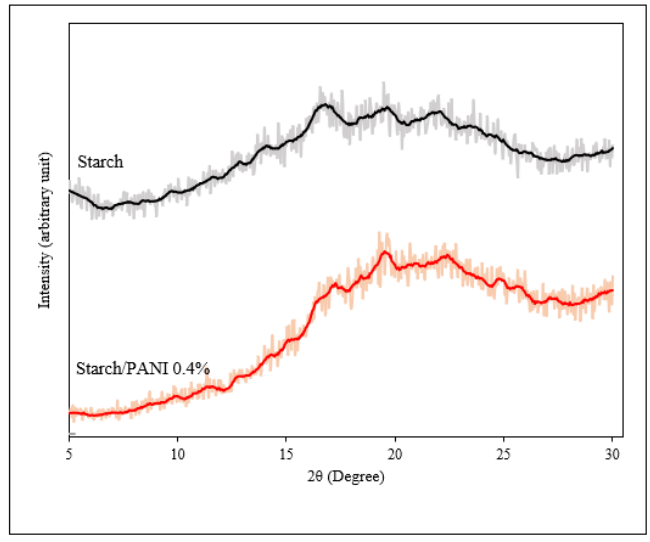
Figure 5. XRD diffractograms of starch and starch/PANI 0.4% polymer films (The actual experimental data and smoothed data were represented by the shadow and solid lines, respectively).